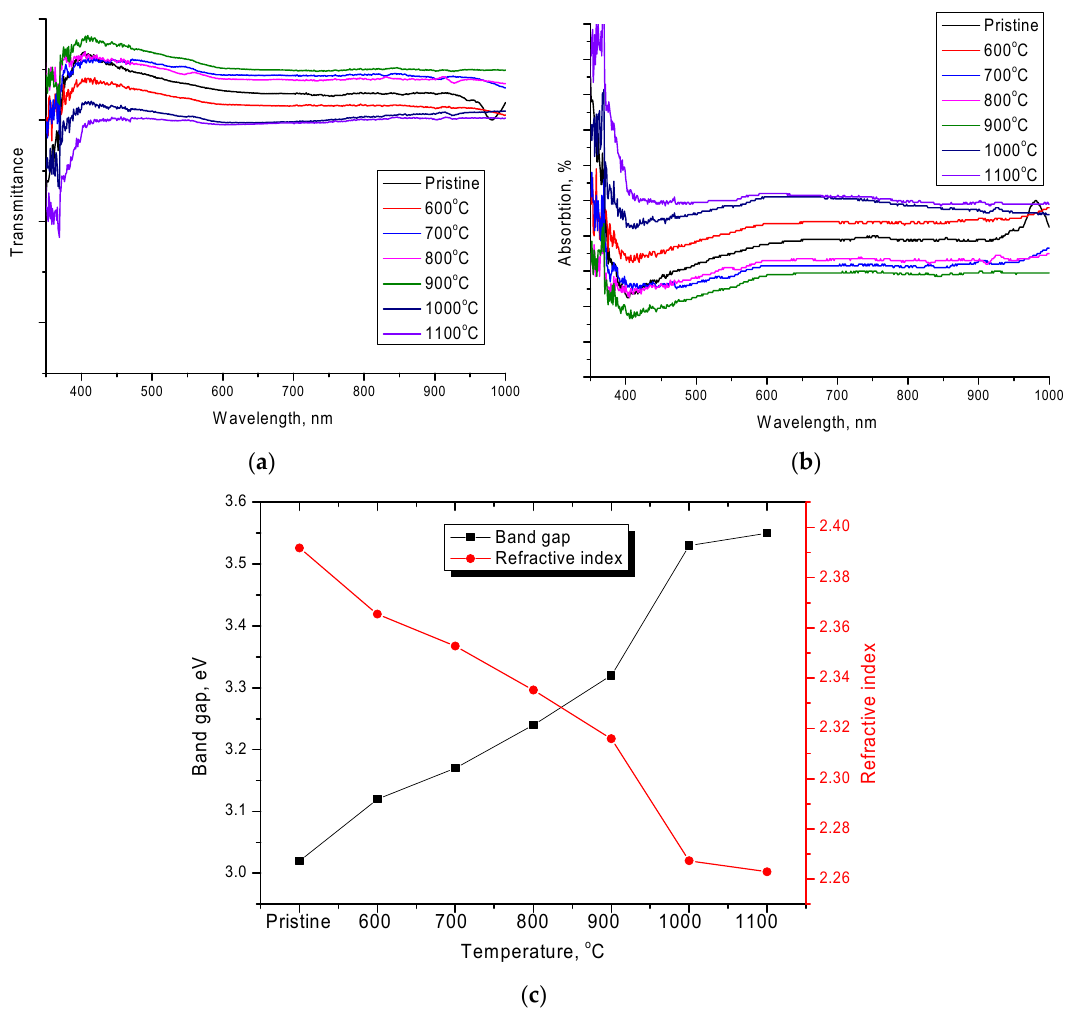
Figure 5. UV-Vis spectra of the studied Li 2 ZrO 3 ceramics: ( a ) transmittance; ( b ) absorption; ( c ) results of change in the band gap and refractive index.